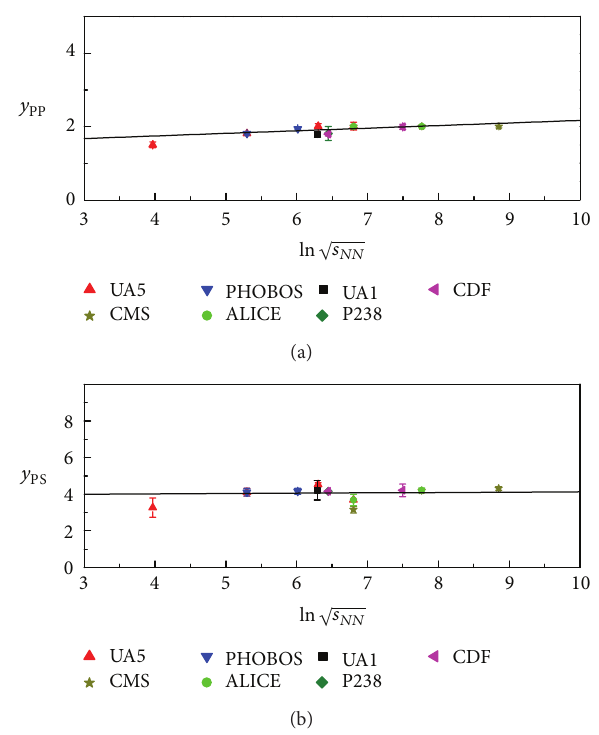
Figure 5: Correlations between 𝑦 and ln √ 𝑠 𝑁𝑁 (b), where √ 𝑠 𝑁𝑁 is in the units of GeV. The symbols represent the values of rapidity shifts 𝑦 1–3 and listed in Table 1 and the lines are our fitted results.